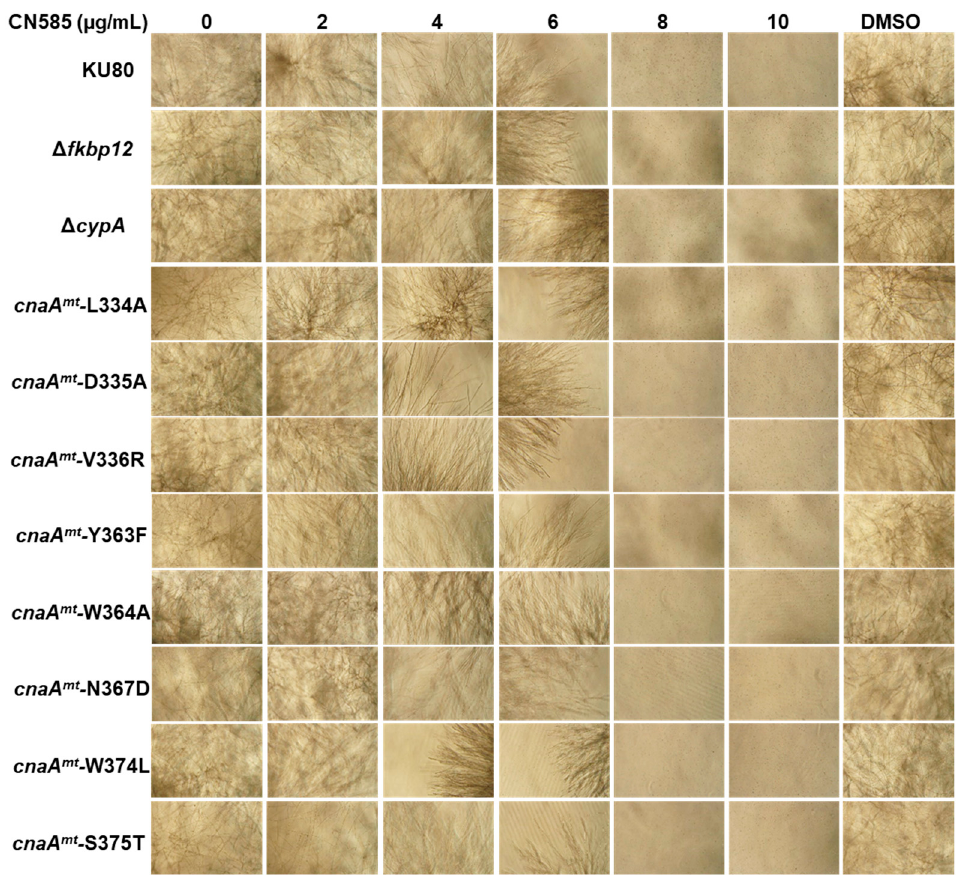
Figure 2. Growth of the wild-type A. fumigatus (KU80), FK506-binding protein deletion ( Δ fkbp12 ), cyclophilin A deletion ( Δ cypA ) and the various cnaA mutant strains in the presence of increasing concentrations of CN585. DMSO control growth is shown. Growth was monitored for 2 days in RPMI at 37 °C. Light microscopy photographs (×10 magnification) after 2 days of growth are shown. Note the complete inhibition in growth for all the strains at >8 µg/mL CN585. Growth susceptibility assays were performed twice in triplicate.